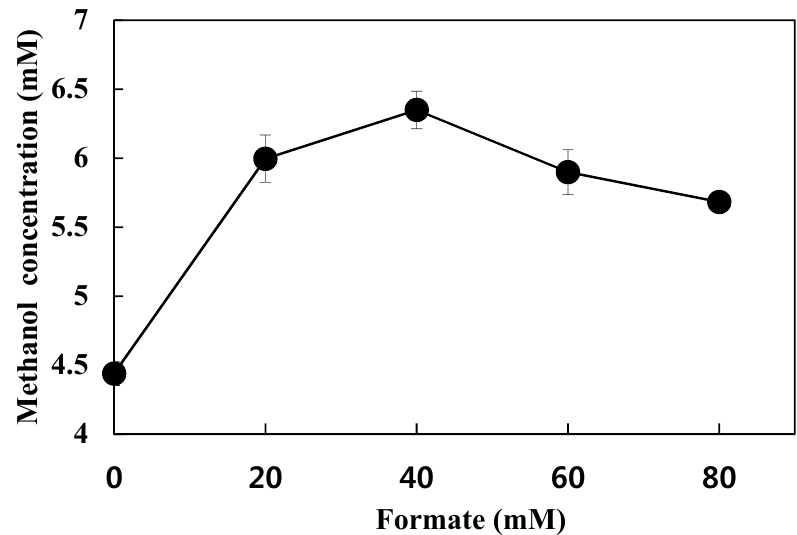
Figure 6. Effect of formate concentration on methanol production from biogas and NaCl (60 mM) in treated wastewater medium.